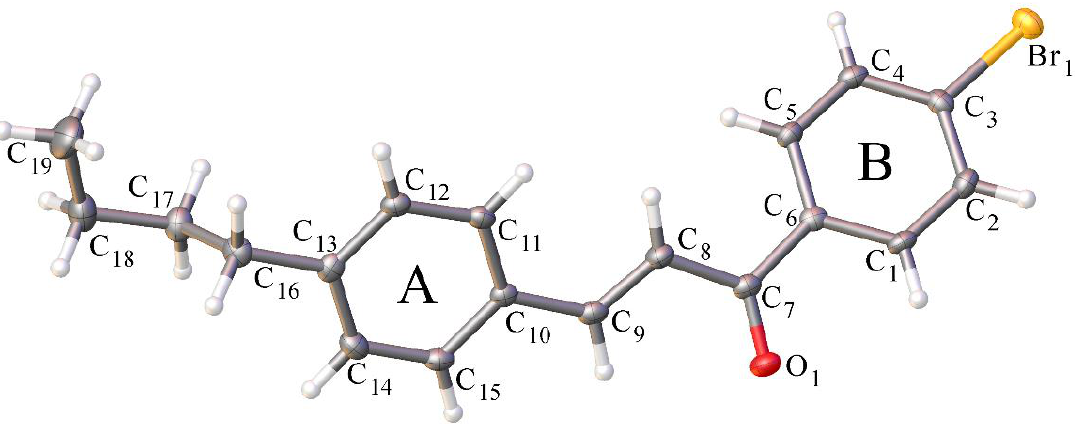
Figure 9. Ortep diagram showing BBP molecule in the asymmetric unit drawing with 50% probabil- ity ellipsoid.